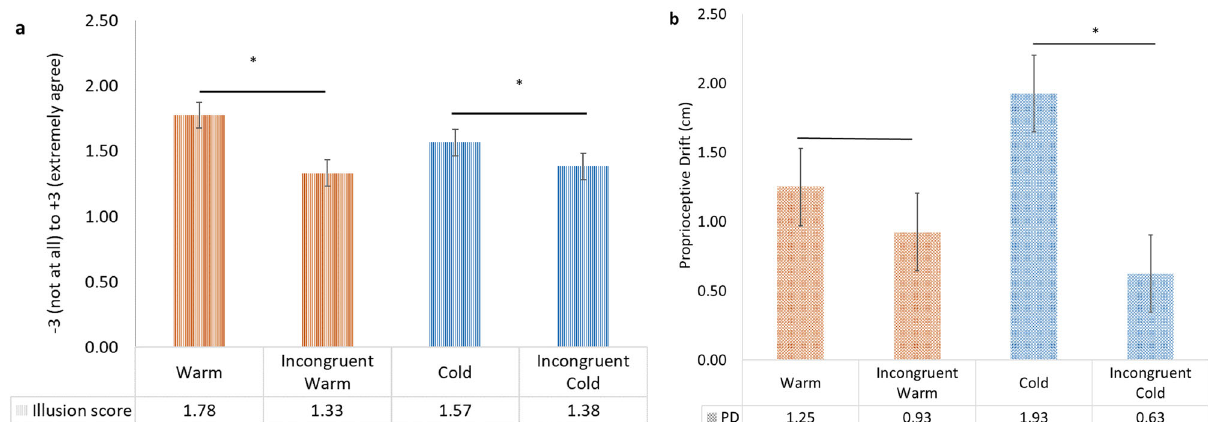
Fig. 1 Illusion score and proprioceptive drift results for Experiment 1. a Mean and standard errors for the composite illusion score (mean score of questionnaire Items 1 – 3. b Mean and standard errors for proprioceptive drift (PD). See Supplementary Fig. 1 and Supplementary Fig. 2 for fi gures with individual data points.